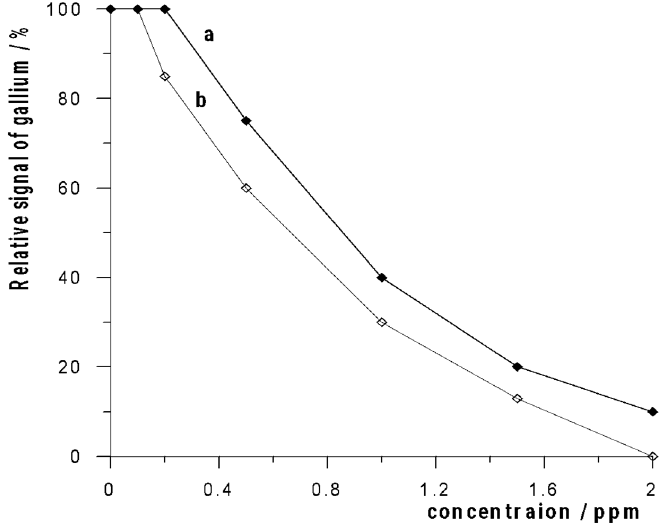
Figure 6. The influence of surface-active substances: Triton X-100 (a) and CTAB (b) on relative signal of 5 × 10 − 7 mol L − 1 Ga(III).